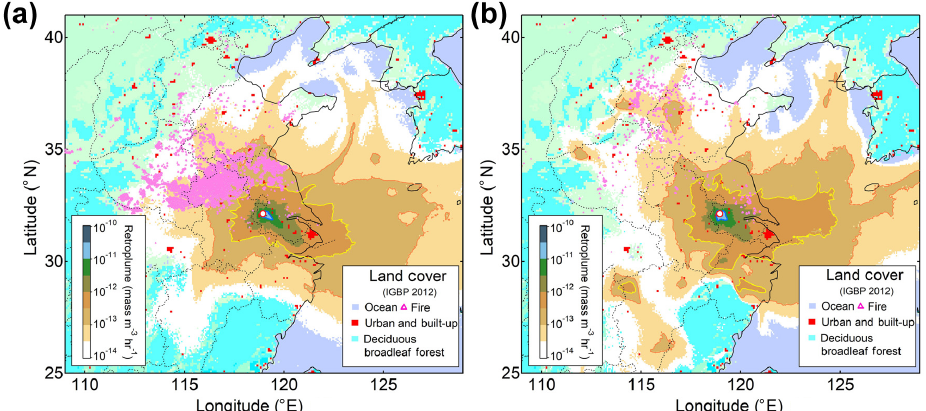
Figure 4. Averaged retroplume from 2d backward Lagrangian dispersion modeling and MODIS fire counts for the period of 15 May–20 June during (a) 2012–2014 and (b) 2016–2018.